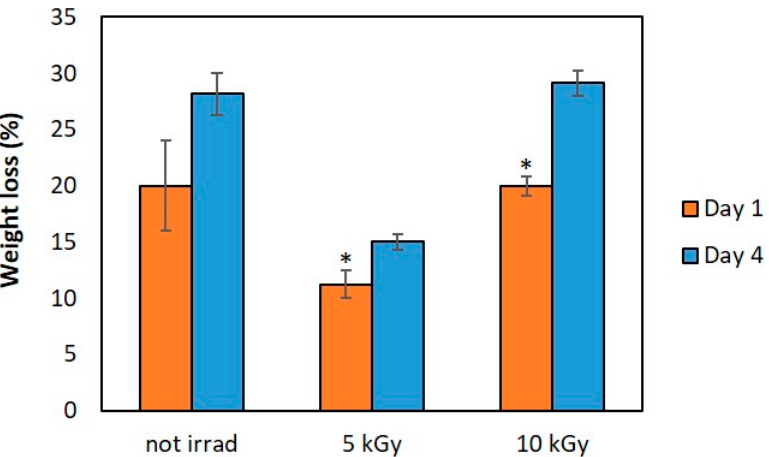
Figure 7. In vitro weight loss of BF chitosan/PVP matrices with 5% PVP content in physiological solution. Data expressed as mean ± SD ( n = 3; * p < 0.05).